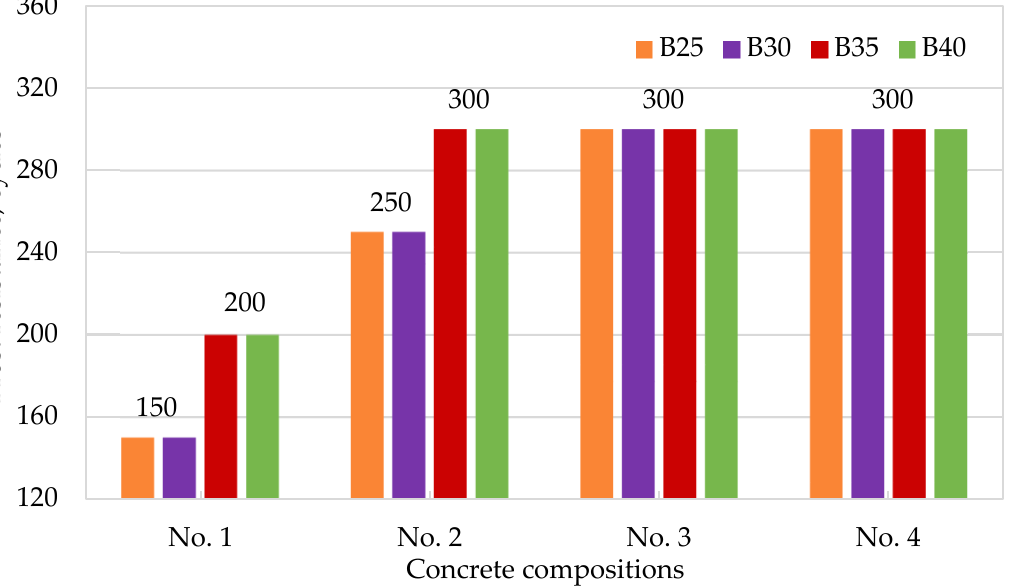
Concrete compositions Figure 6. Dependence of volumetric water absorption of concrete on the application of modifiers and volumetric fiber reinforcement: No. 1—no additives; No. 2—with CCM; No. 3—with CCM and HPC; No. 4—with CCM, HPC, and fiber.